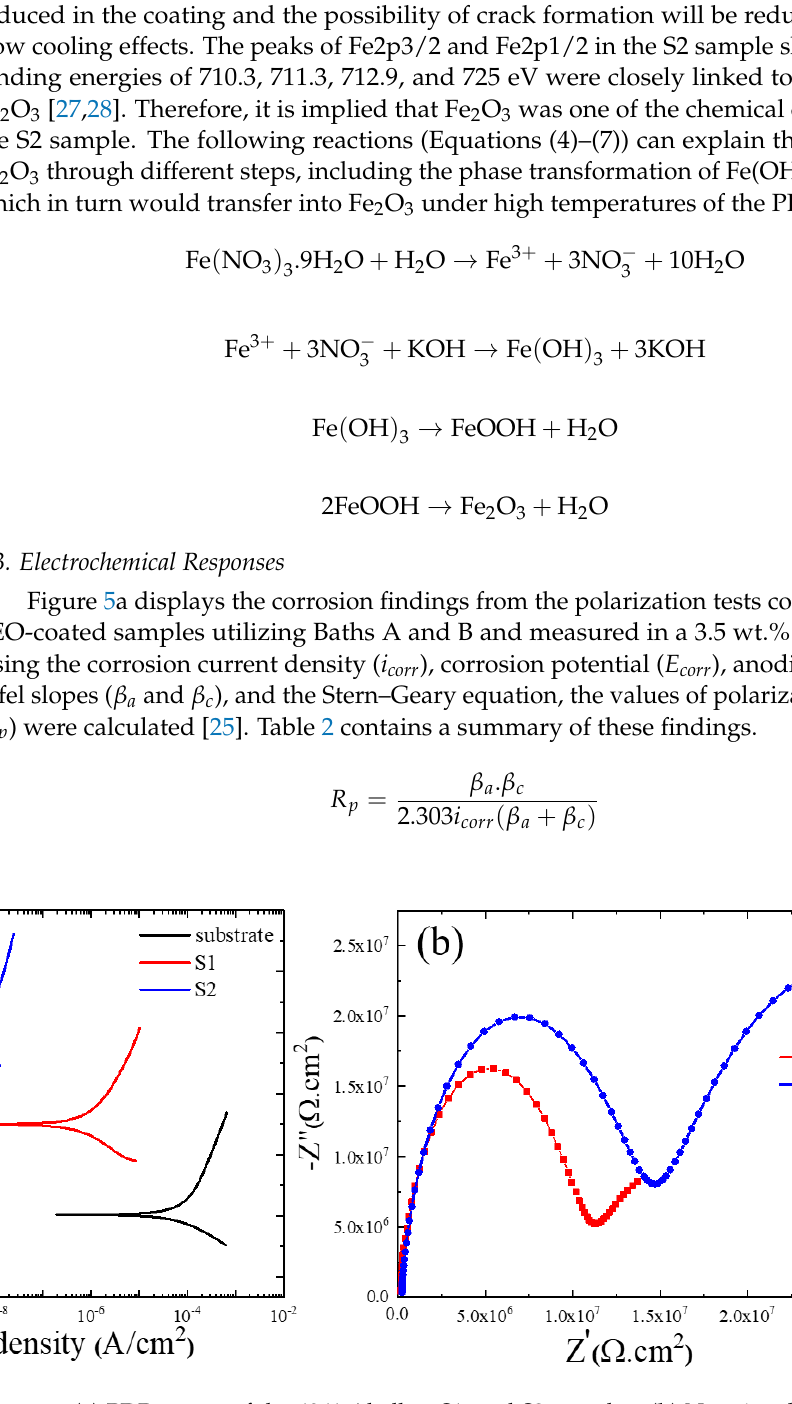
Figure 5. ( a ) PDP curves of the 6061 Al alloy, S1, and S2 samples. ( b ) Nyquist plots of S1 and S2 samples in a 3.5 wt.% NaCl solution. Table 2. Results of PDP tests of the bare substrate, S1, and S2 samples immersed in a 3.5 wt.% NaCl